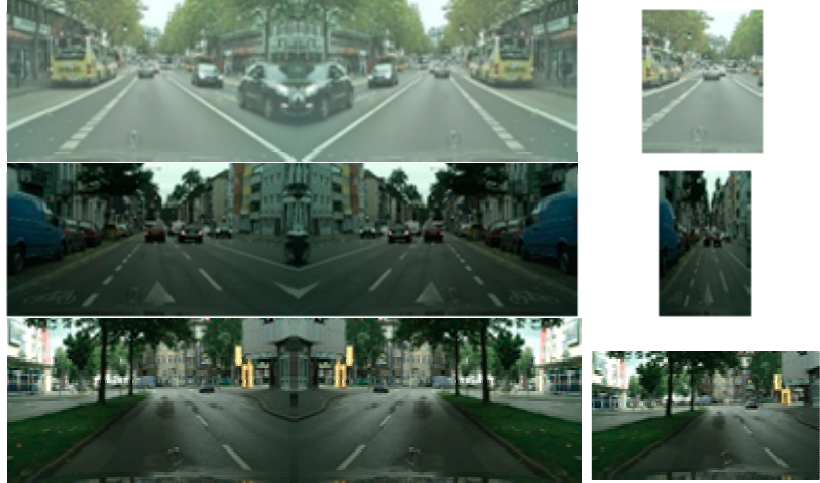
Figure 17. Image enhancement of the Cityscapes dataset.